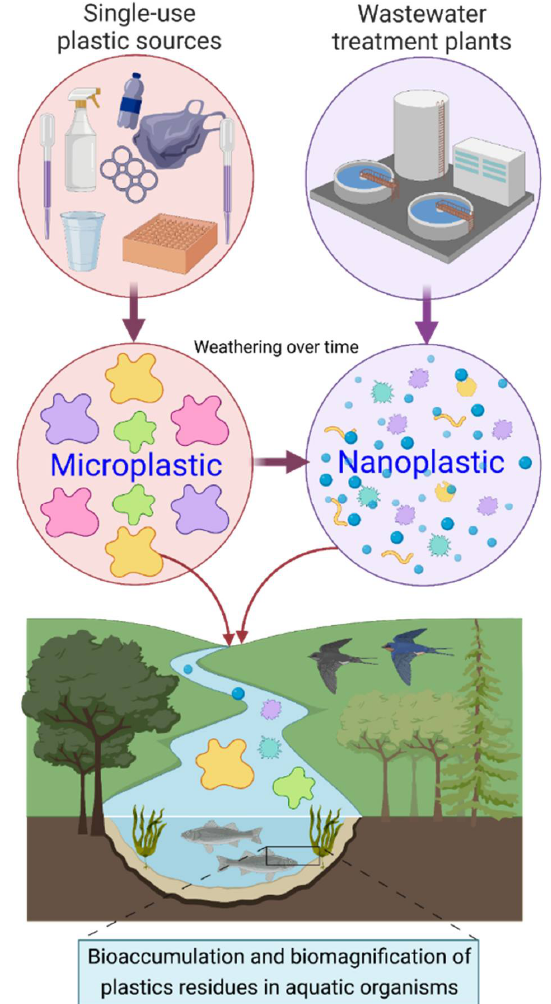
Figure 1. A schematic representation of various plastic sources, their ultimate weathering over time